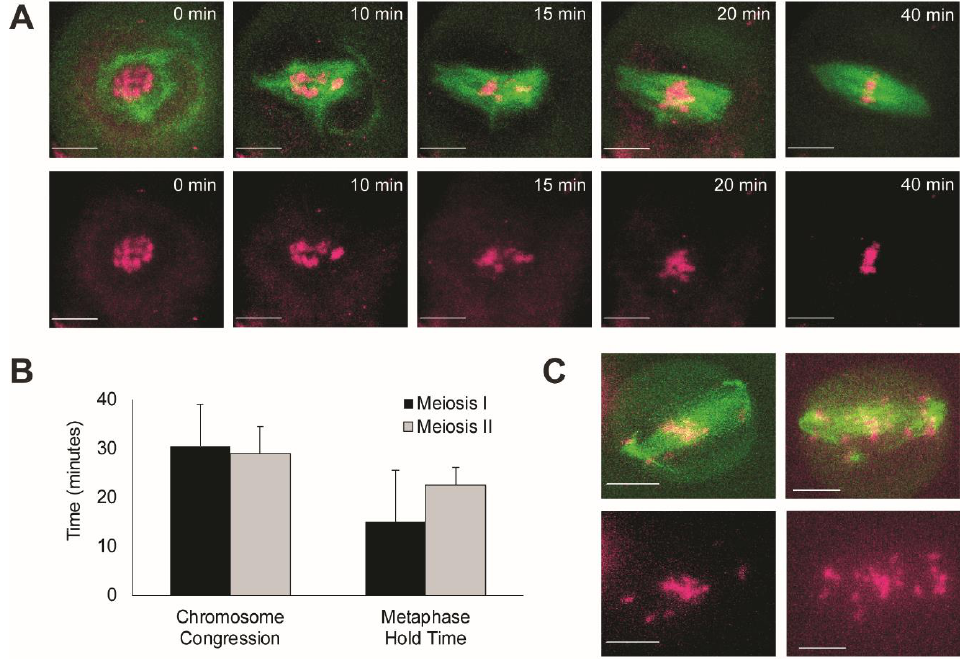
Figure 3. Dynamics of chromosome congression and alignment on the spindle. ( A ) Example movie of chromosome congression dynamics during spindle assembly; chromatin (magenta) labelled via SYTOTop panel: overlay microtubules (green) and chromosomes (magenta); bottom panel: chro- mosomes alone. ( B ) Average chromosome congression time and metaphase hold time; error bars represent standard deviation. ( C ) Example images of failed chromosome congression; congression failed in 3 of 63 cells. Scale bars: 10 µ